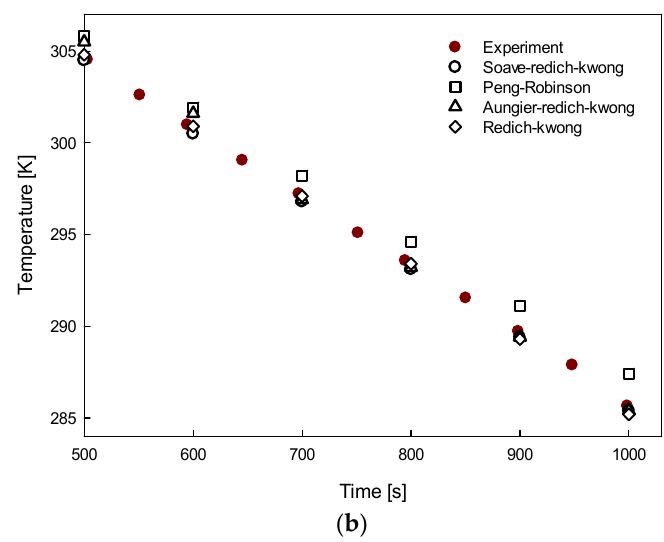
Figure 2. Averaged temperatures of the inner gas tank for the different gas models and experimental results for the hydrogen discharge case. ( a ): Early stage, ( b ): Developed stage.